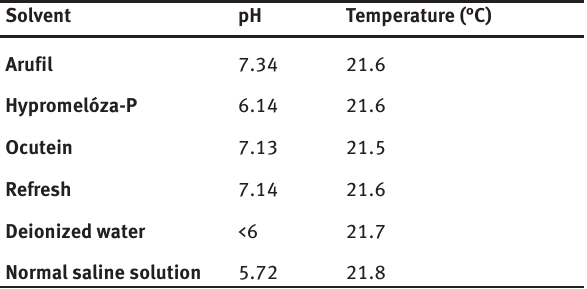
Table 3: pH values of eye drops (Arufil, Refresh, Ocutein, Hypromelóza-P), deionized water and normal saline solution